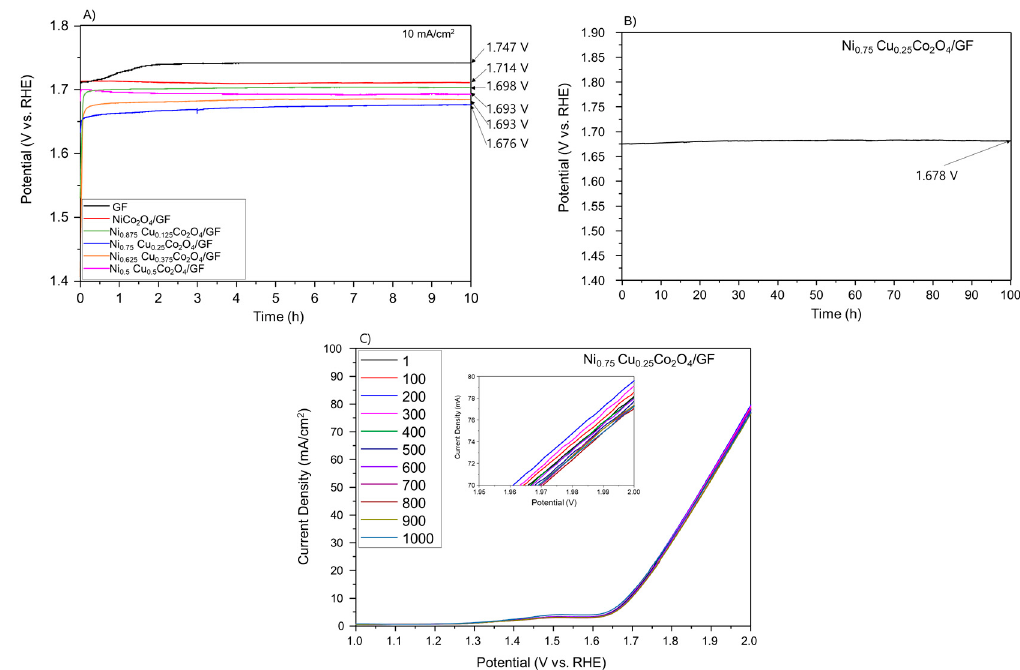
Figure 8. Chronopotentiometry of all electrodes for 10 h at 10 mA cm − 2 ( a ), Chronopotentiometry for 100 h on the Ni 0.75 Cu 0.25 Co 2 O 4 /GF electrode ( b ), and 1000th cycled LSV curves for the Ni 0.75 Cu 0.25 Co 2 O 4 /GF electrode ( c ).